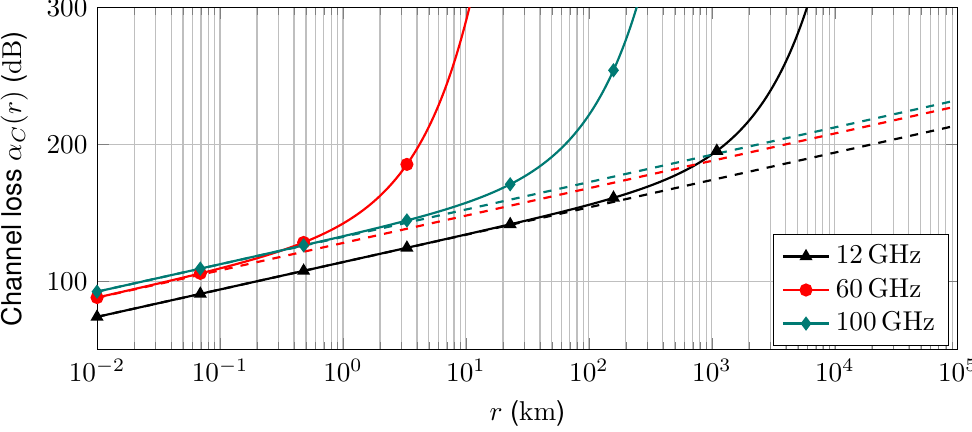
Figure 1. Channel attenuation versus transmission range. Dashed lines represent free-space loss, while solid lines represent the combination of free-space loss together with atmospheric attenuation